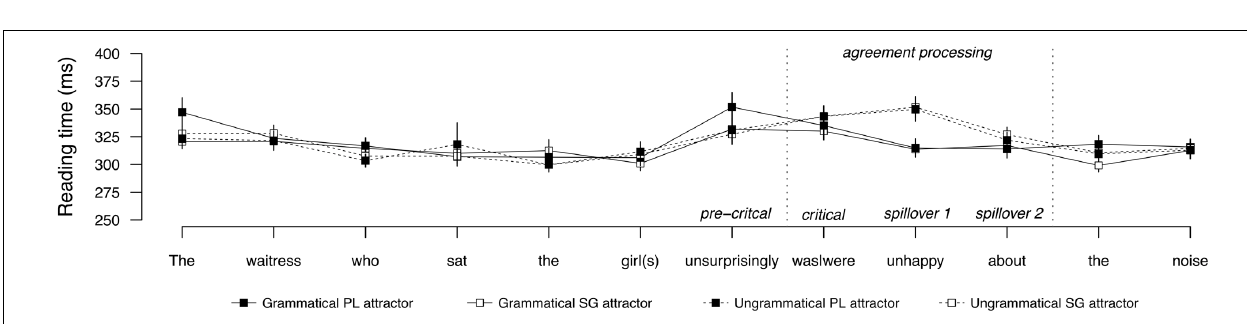
Frontiers in Psychology |